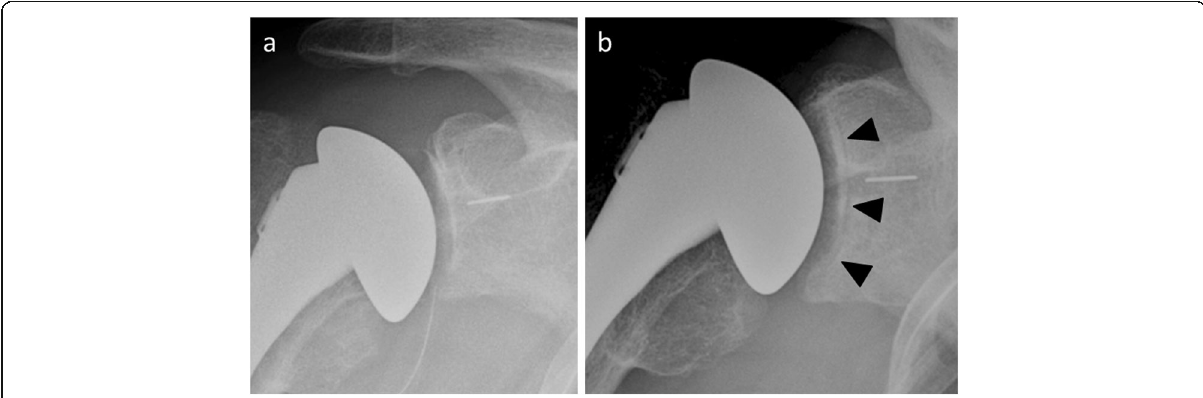
Fig. 18 a Normal postoperative anteroposterior shoulder radiograph of a 51-year-old man with total shoulder arthroplasty. b Anteroposterior radiograph in the same patient as a 4 years later shows a radiolucent line around the glenoid implant (arrowheads), while the patient is